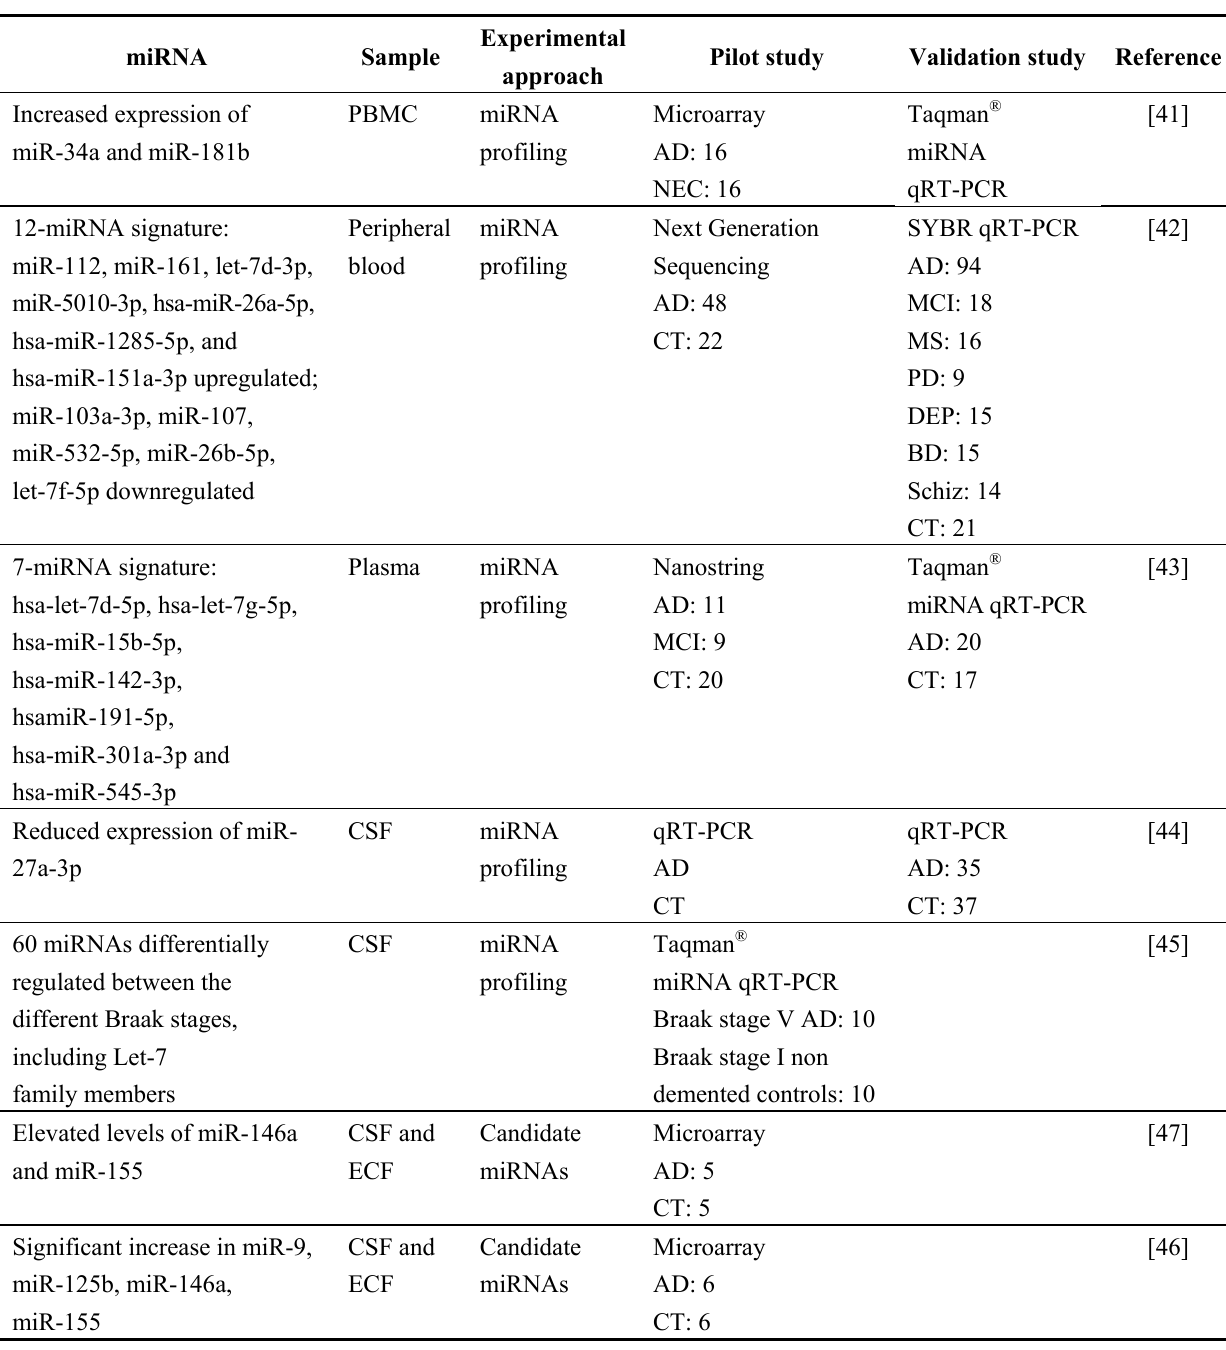
Table 1. Alzheimer’s Disease and circulating